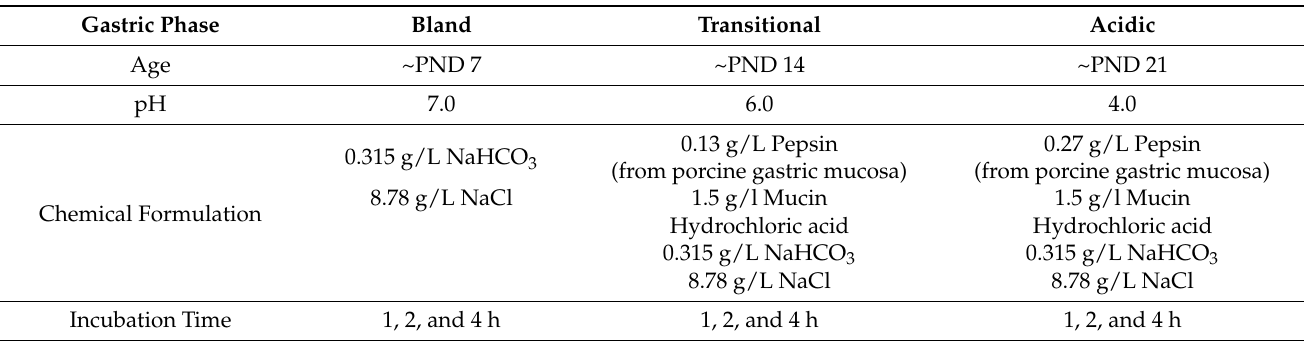
Table 1. Chemical formulation of in vitro rat gastric fluid reflecting different postnatal ages tested in this study and time (h) of